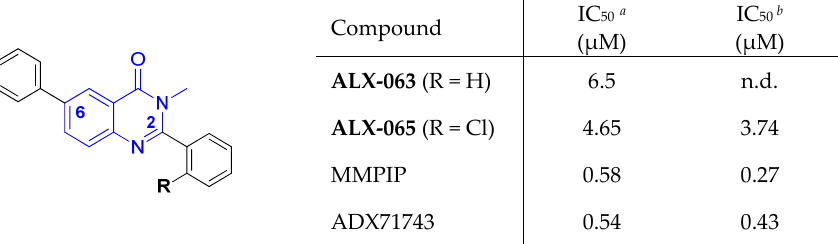
Figure 5. Structures of hit and tool compounds and mGlu 7 NAM activities determined with a T-REx 293 cell line [41] and b CHO-K1 cell line methods reported in the Supplementary Materials—Sections